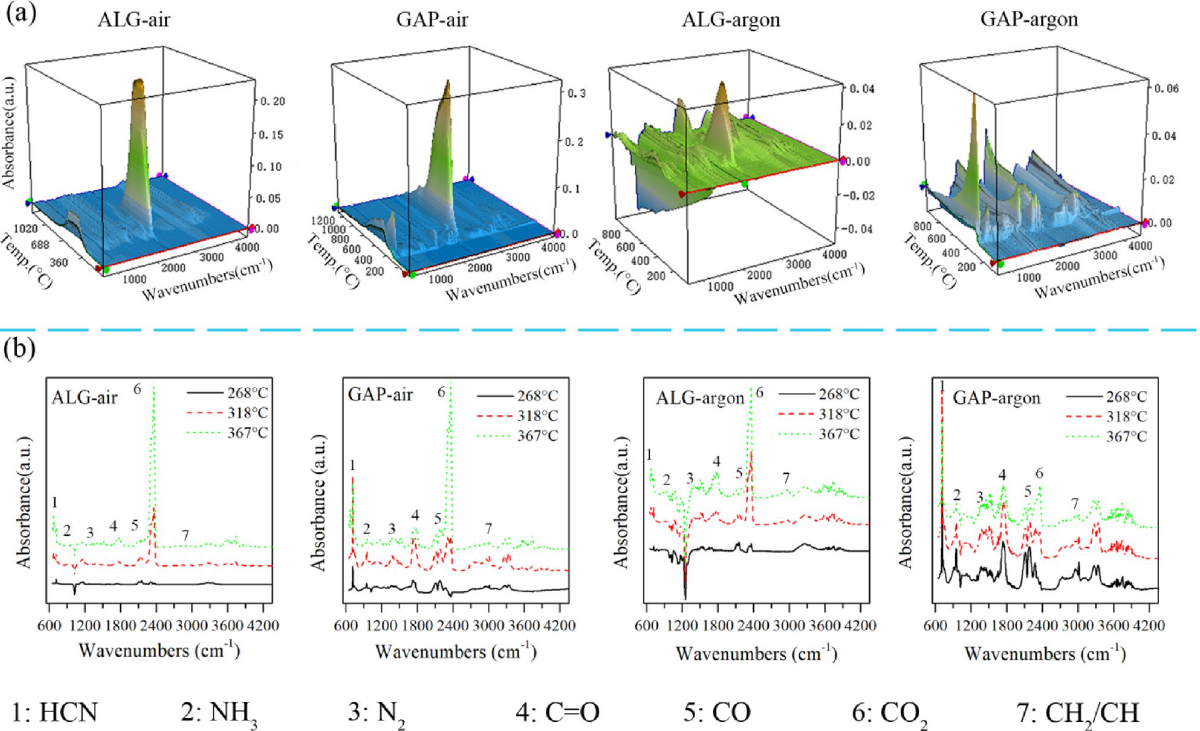
Figure 4. 3-D FTIR spectra ( a ) and the corresponding FTIR spectra ( b ) of decomposition products of ALG and GAP in air and argon